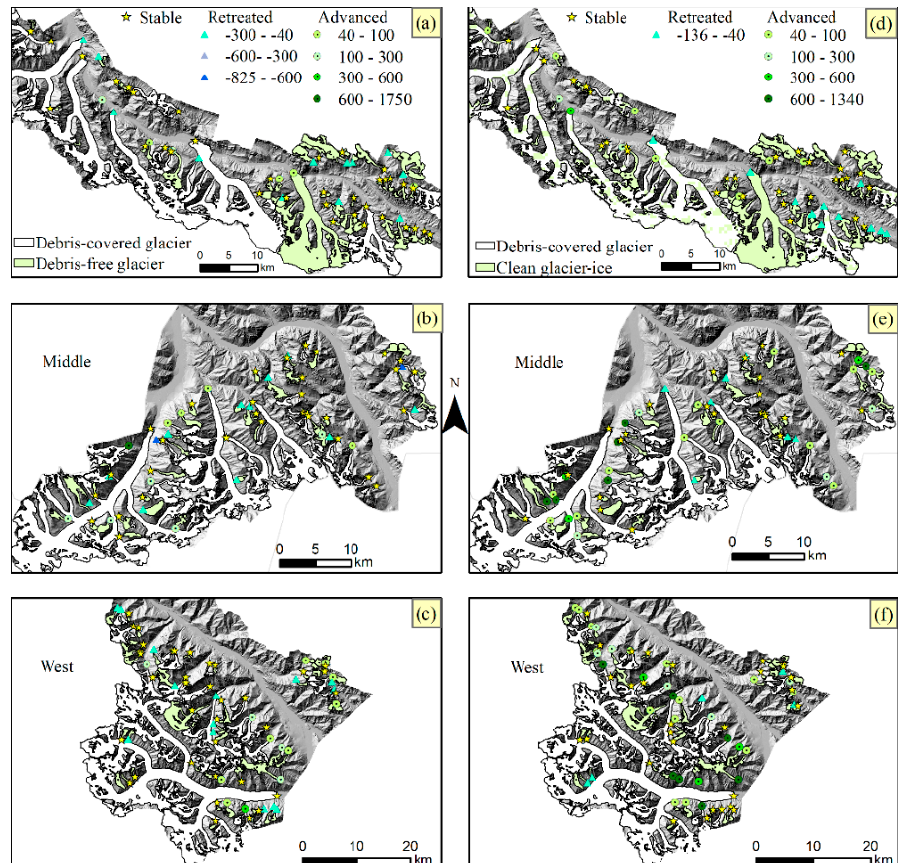
Figure 14. Variations of glaciers terminus position during the 1990–2000 ( a – c ) and 2000–2014 ( d – f ) periods (unit: meter).